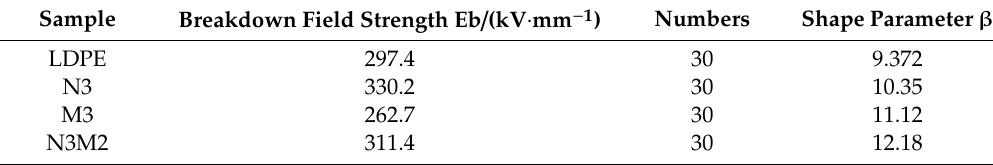
Figure 7. Weibull distribution curve of the samples in the DC field. Table 4. DC breakdown characteristics of different samples.